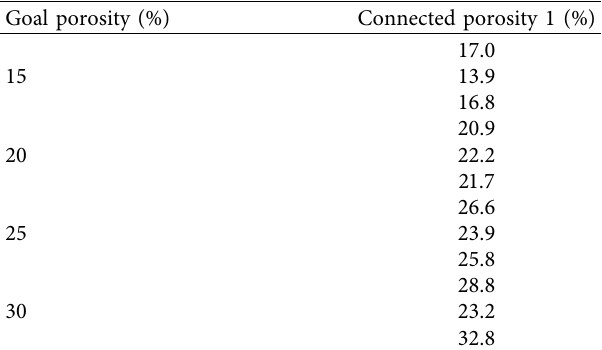
Table 9: Test results of specimen with 150mm × 150mm × 550mm. Goal porosity (%)